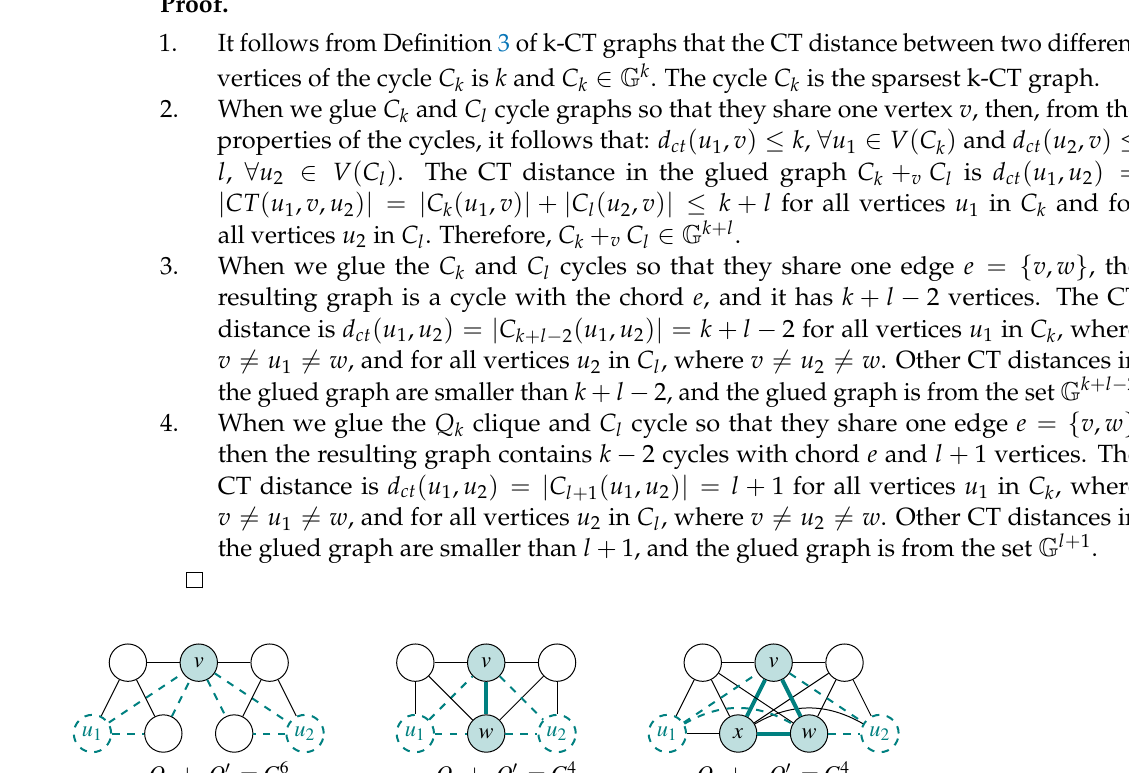
) . From the second and third pictures, it is u 1 , u 2 V ( Q 4 + v Q (cid:48) 6 4 ≤ ∀ ∈ ) . Glued two cliques via u 1 , u 2 V ( Q k + Q Q (cid:48) 4 k p ≤ ∀ ∈